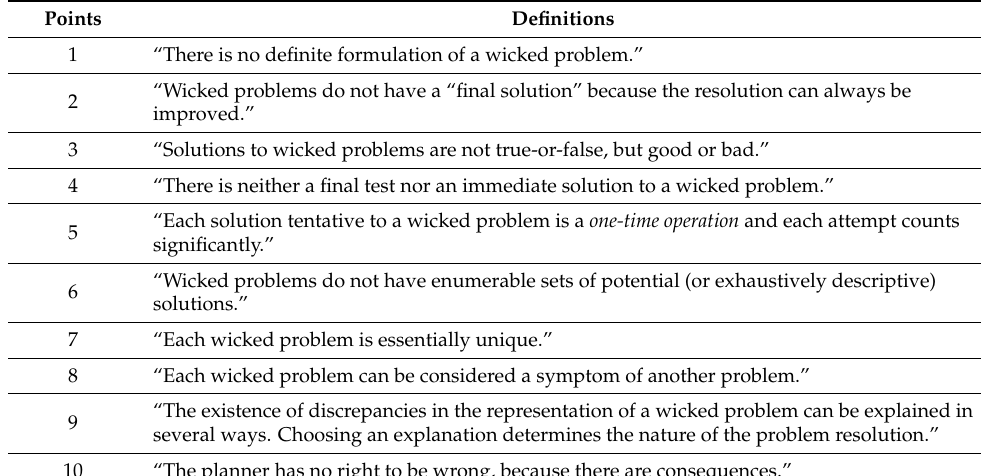
Table 1. Summary of the Ten Wicked Problem Points, adapted from [20,30] and [23] (p. 29).